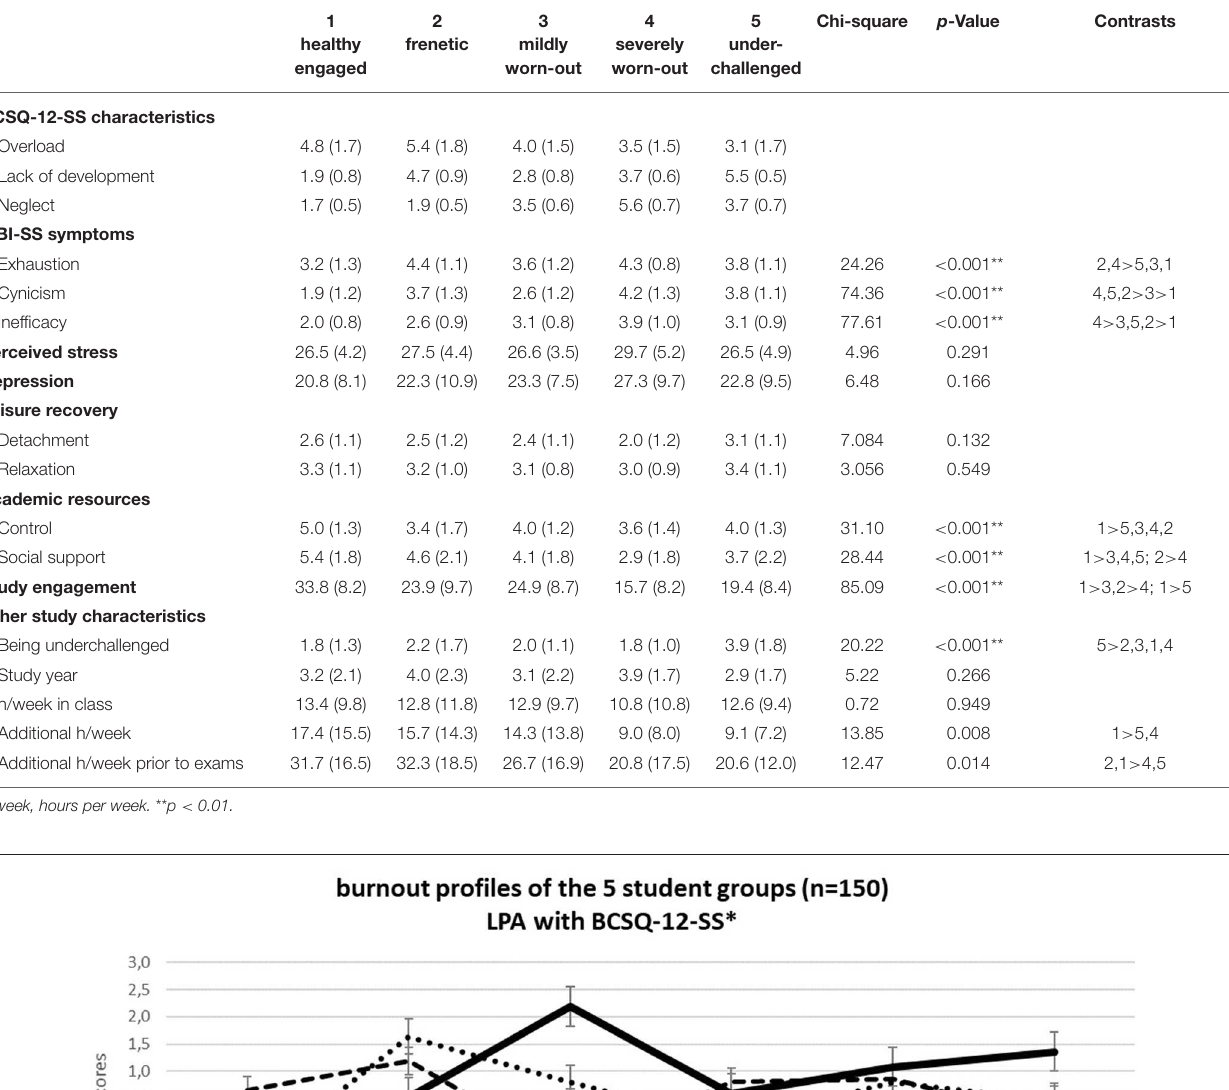
TABLE 7 | Burnout, stress, and study characteristics of the five BCSQ-12-SS classes in the stressed subsample.